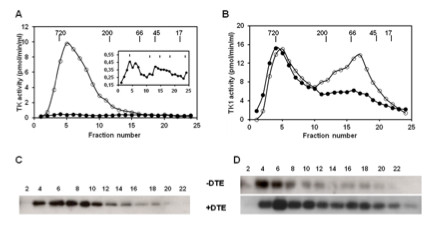
Quaternary structure of recombinant TK1 and the effect of reducing agent. Untreated (●) or DTE-treated (○) recombinant canine (A) and human (B) TK1 was analyzed by size exclusion chromatography. Four micrograms of freshly isolated TK1 in 200 μl buffer were injected into the column and eluted. A total of 24 fractions were collected. TK1 activity in the fractions was determined by radiochemical assay and TK1 protein was detected by immunoaffinity detection method as described in Materials and Methods. Inset: activity profile of untreated recombinant canine TK1. Arrows indicate the elution position of molecular weight markers. Western blot analysis of FPLC fractions of canine (C) and human (D) TK1; untreated (−DTE), and DTE-treated (+DTE). The numbers represent FPLC fractions.